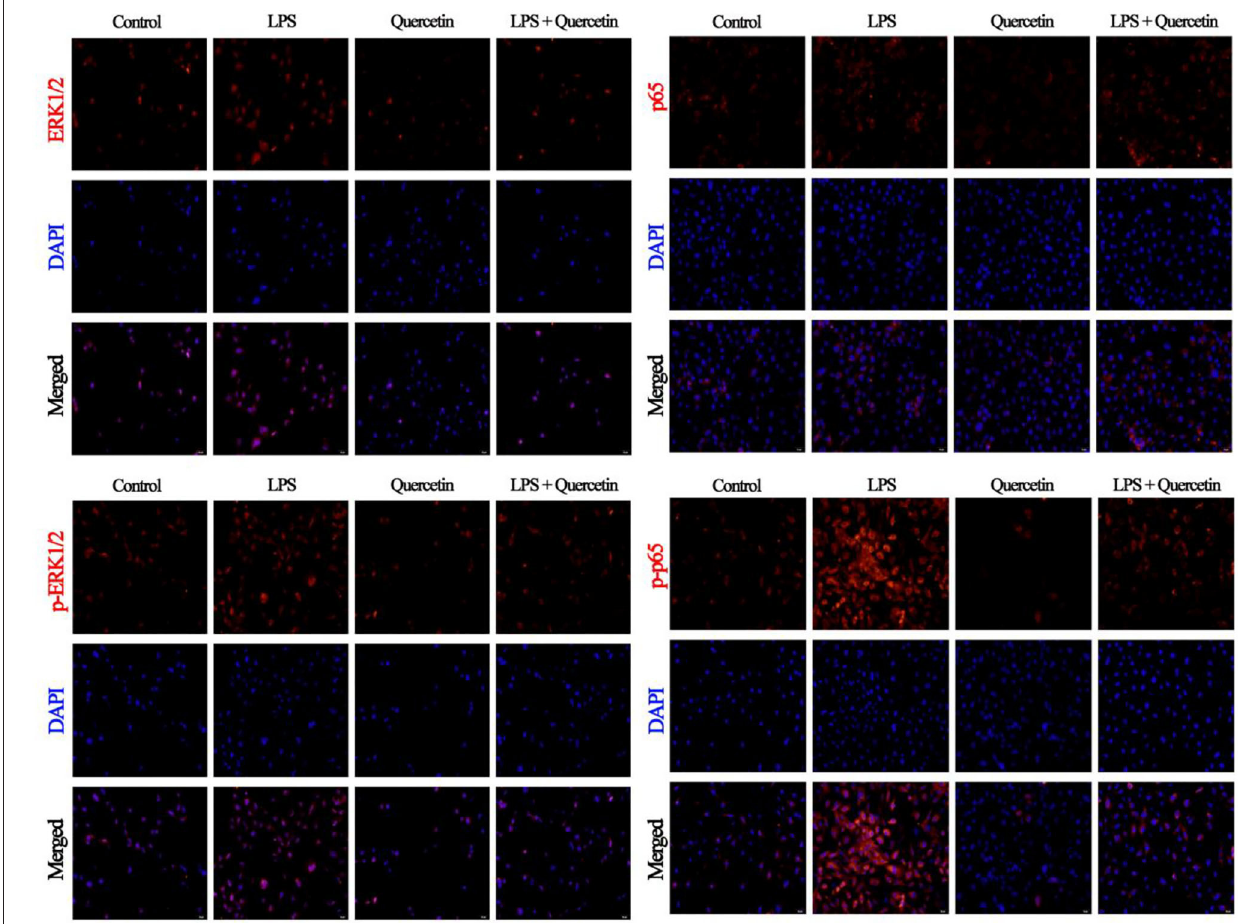
FIGURE 7 | Effects of quercetin on NF- κ B p65 and ERK1/2 signaling pathway in LPS-induced BMECs. BMECs were treated with 100 µ g/ml of quercetin in the presence of 1 µ g/ml of LPS for 6h. The immunofluorescence for NF- κ B p65 and ERK1/2 (red) was performed, and the nuclear dye 4 ′ , 6-diamidino-2-phenylindole (DAPI; blue) was used. Scale bar = 50 µ